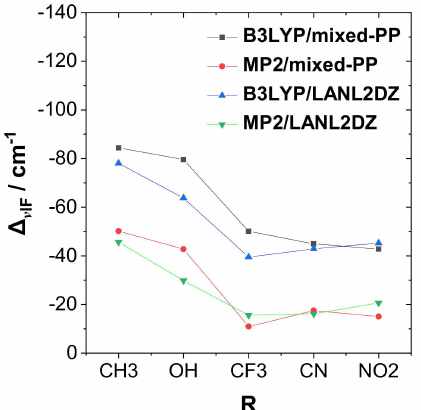
Figure 2. Calculated trend of ∆ E bind with substituent R in the RPH 2 ··· IF complexes for four theoretical levels. Note the reversed ordering of the cyano substituent e ff ect on binding energy when di ff use functions are absent (“pure” LANL2DZ; see text).